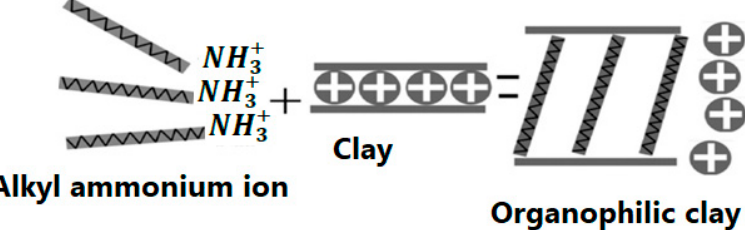
Figure 4. Schematic representation of an ion-exchange reaction.